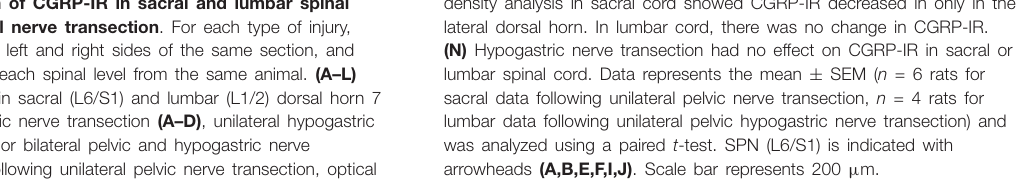
FIGURE 5 | Distribution of CGRP-IR in sacral and lumbar spinal cord following visceral nerve transection . For each type of injury, images were taken from left and right sides of the same section, and transverse segments of each spinal level from the same animal. (A–L) Images show CGRP-IR in sacral (L6/S1) and lumbar (L1/2) dorsal horn 7 days after unilateral pelvic nerve transection (A–D) , unilateral hypogastric nerve transection (E–H) or bilateral pelvic and hypogastric nerve transection (I–L) . (M) Following unilateral pelvic nerve transection, optical